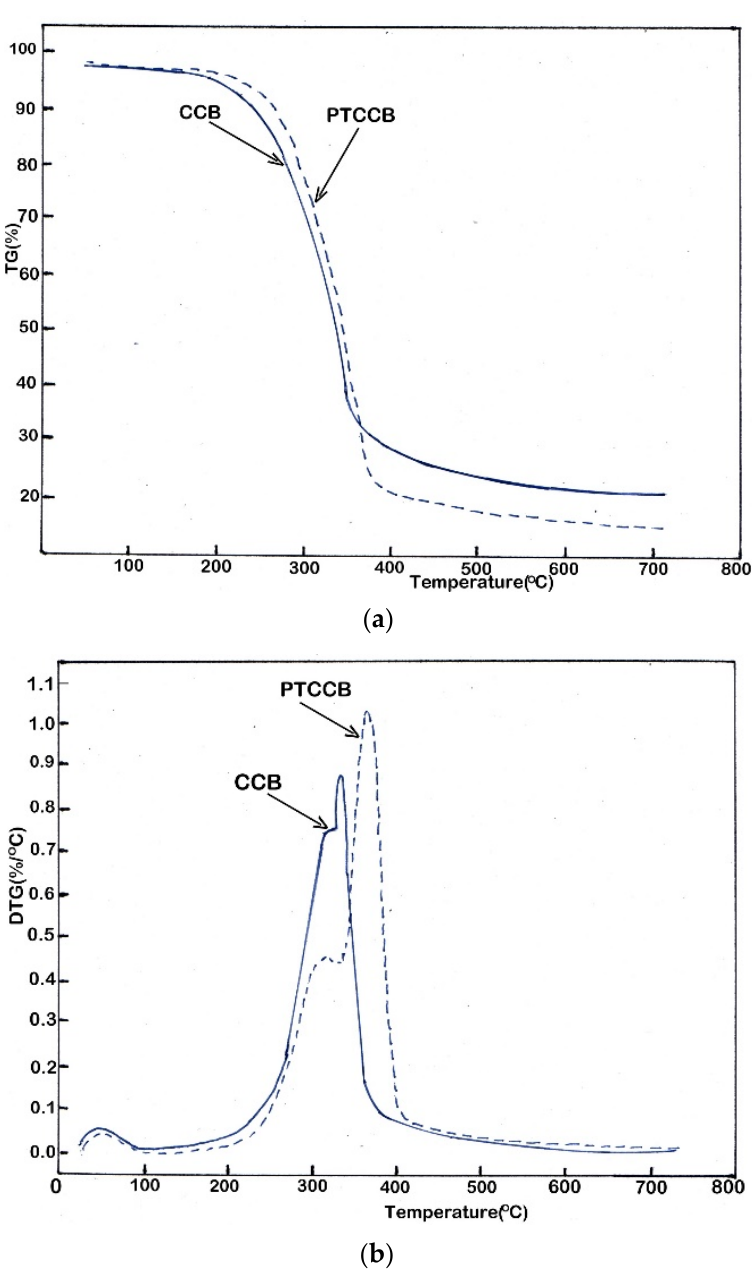
Figure 4. The profile of TG ( a ) and DTG ( b ) curves obtained for CCB and PTCCB samples.